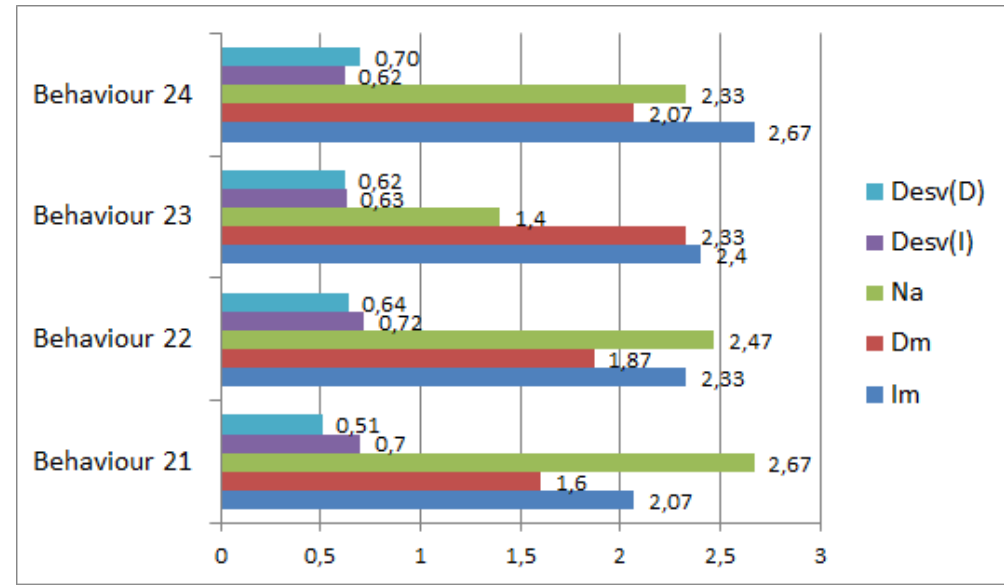
Figure 5. Productive questioning.